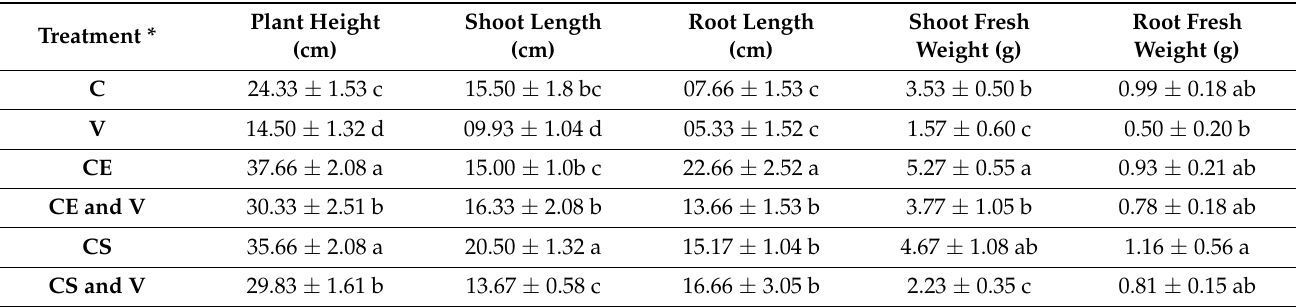
Figure 5. Effect of the foliar application of nanoclays on PVY on potato plants under greenhouse conditions. C: control potato plants; V: potato plants inoculated with PVY; CE: potato plants treated with Egyptian nanoclay; CE and V: potato plants inoculated with Egyptian nanoclay 48 h before PVY inoculation; CS: potato plants treated with standard nanoclay; CS and V: potato plants inoculated with standard nanoclay 48 h before PVY inoculation. Table 4. Effect of Egypt and standard nanoclays on the growth parameters of potato plants infected with PVY (28 days after inoculation). C: control potato plants; V: potato plants inoculated with PVY; CE: potato plants treated with Egyptian nanoclay; CE and V: potato plants inoculated with Egyptian nanoclay 48 h before PVY inoculation; CS: potato plants treated with standard nanoclay; CS and V: potato plants inoculated with standard nanoclay 48 h before PVY inoculation.